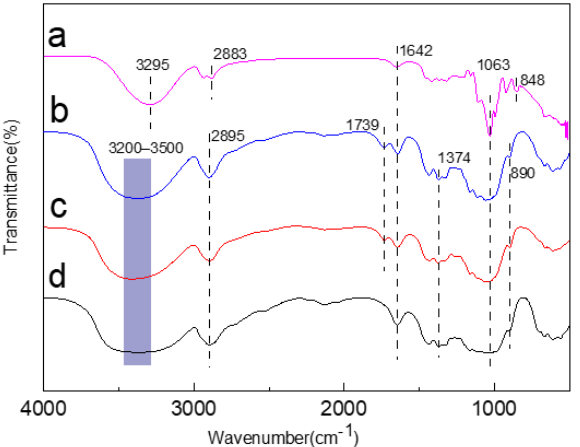
Figure 2. FTIR spectrum of jute MCC membrane (a), jute MCC (b), jute cellulose (c), and standard MCC (d). MCC